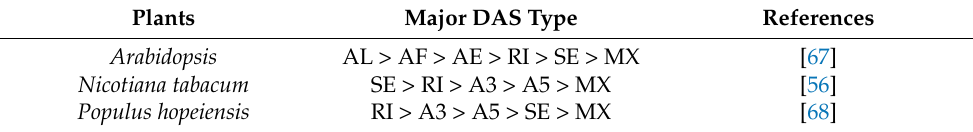
Table 1. Differential splicing type (DAS) statistics of different plants induced by abscisic acid. Plants Major DAS Type Arabidopsis AL > AF > AE > RI > SE > MX [67] Nicotiana tabacum [56] Populus hopeiensis